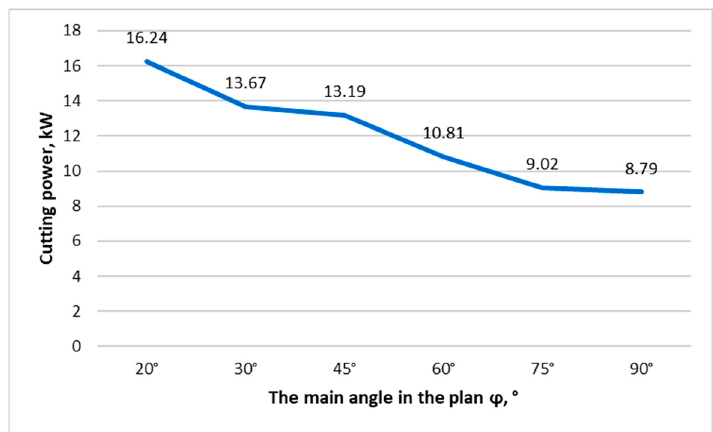
Figure 16. Dependence of the change in cutting power N on the main angle in terms of φ .